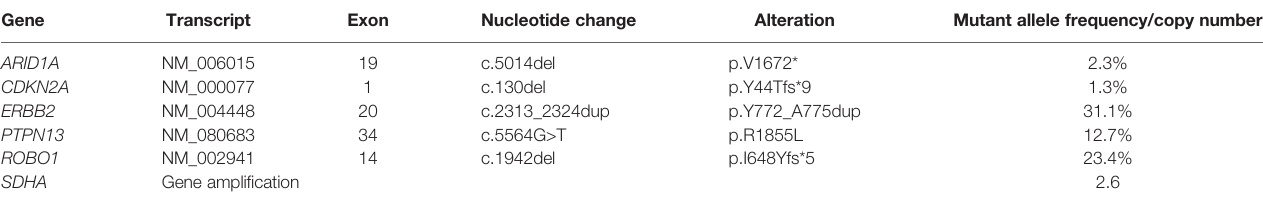
TABLE 3 | Mutation pro fi le of right lung tumor in the patient after resistance to crizotinib. Gene Exon Nucleotide change Alteration Mutant allele frequency/copy